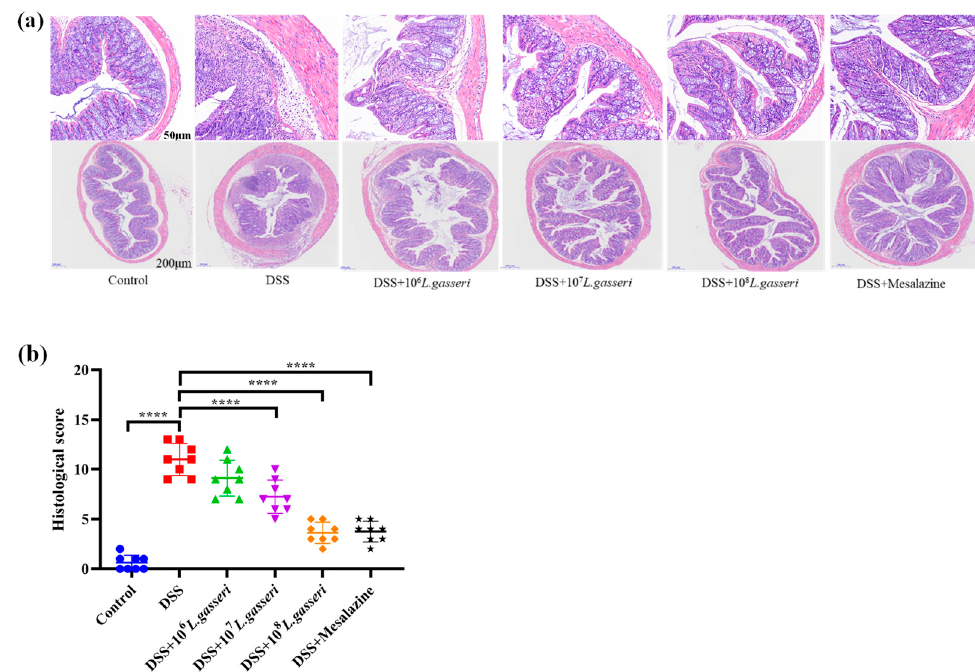
Figure 3. HE staining and histological scores of colitis mice. ( a ) The colonic microsections stained with HE and ( b ) histological score of colitis mice. **** p < 0.0001 represents a significant difference between groups.